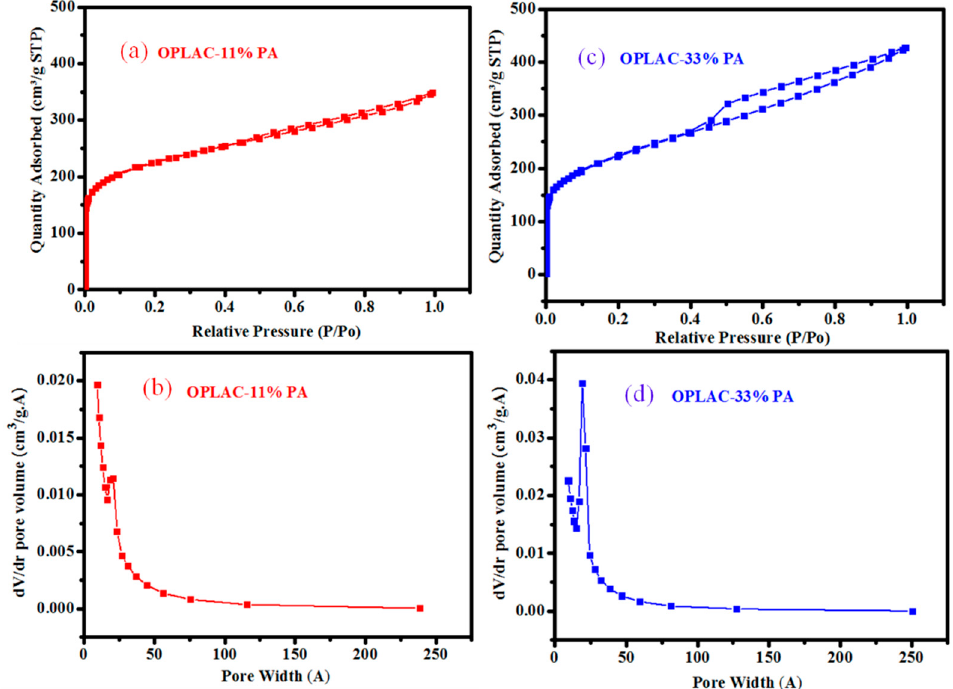
Figure 2. ( a , c ) The nitrogen adsorption–desorption isotherms, at 77 K, of OPLAC-11% PA and OPLAC-33% PA, respectively; and ( b , d ) represents their corresponding pore size distributions. “OPLAC: Oil Palm Leaf-derived Activated Carbon; PA: Phosphoric Acid”.